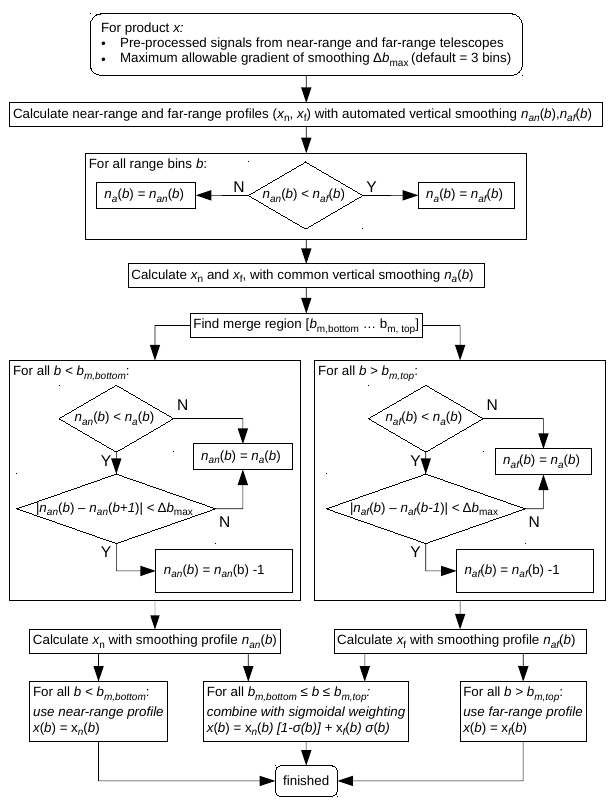
Figure 7. Work flow diagram of the ELDA algorithm to merge op- tical products calculated using data from different telescopes.